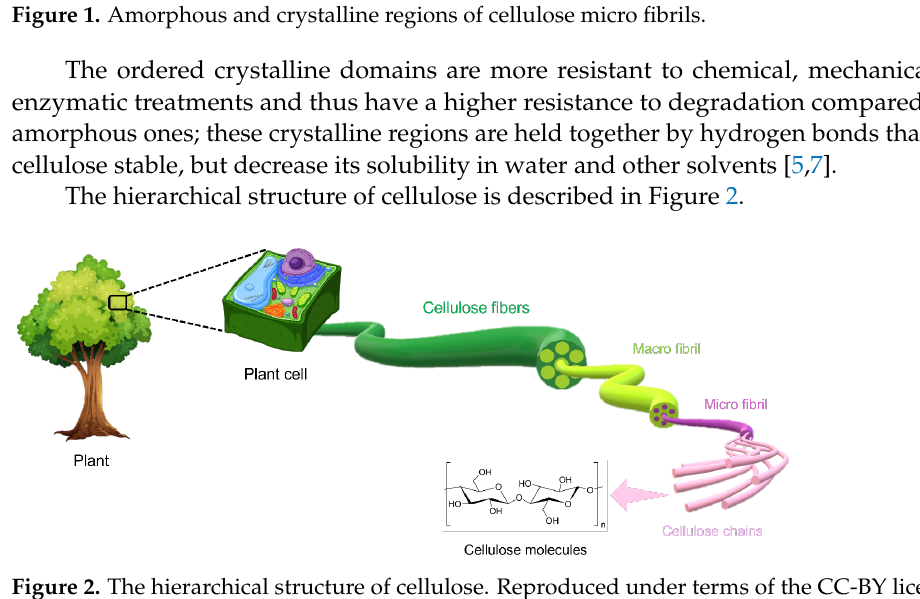
guish three categories of nanocellulose: cellulose nanocrystals (CNCs), nano-fibrillated cellulose (CNF), and bacterial nanocellulose (BNC). CNCs consist of cylindrical, elon- gated, inflexible, and rod-like nanoparticles with dimensions of 4 – 70 nm in width and 100 – 6000 nm in length and a crystallinity index of around 54 – 88 %; they are usually ob- tained by hydrolysis. Nano-fibrillated cellulose (CNF), commonly obtained by mechanical treatment, with a braided network structure, is composed of longer and flexible fibers with dimensions of 20 – 100 nm in width and >10,000 nm in length and a low crystallinity index (<50 %). Finally, bacterial nanocellulose (BNC), also known as microbial nanocellu- lose, is the most promising and cost-effective biomaterial, especially for the biomedical industry, with its highest crystallinity index > 88 % [20]. The BNC consists of ultrafine nanofibers that are 20 – 100 nm in diameter and micrometers lengths that form an identi- fying 3D network [6,20,29]. All of these categories of nanocellulose are related to each other because they can all be obtained from the same natural sources, and each can form stable structures in a liquid medium or matrix via hydrogen bonds. In fact, nanocellulose contains a great number of hydroxyl groups (-OH) that can form hydrogen bonds either between different chains (intermolecular bonds) or in the same chain (intramolecular bonds), making this material highly hydrophilic and allowing us to modify it via different chemical and physical strategies [4]. Its hydrophilicity can sometimes be a drawback, es- pecially in the case of applications where humidity can be a problem [10]. Consequently, chemical modifications on hydroxyl groups are often carried out in order to decrease the hygroscopicity of nanocellulose [30].